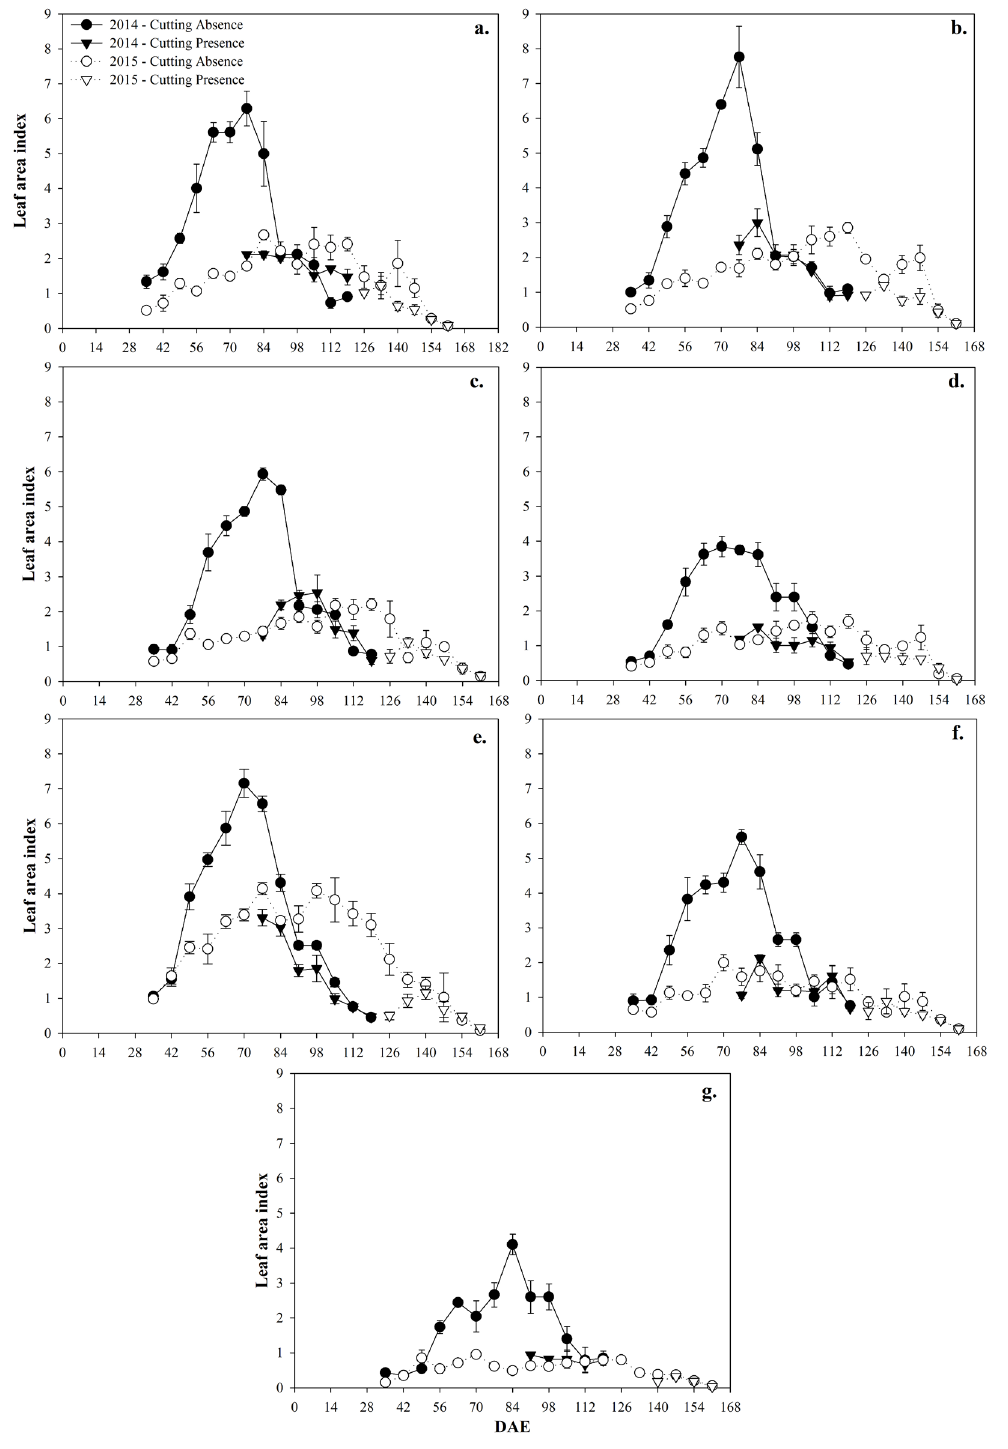
Figure 6 - Leaf area index (LAI) in days after emergency (DAE) dual-purpose wheat cultivated in different cropping systems and with or without a cut (grazing simulation) in the crop years of 2014 and 2015 (Crop Seasons I and II, respectively). S.parahyba Intercrop-I (a) ; P.rigida Intercrop-I (b) ; P.dubium Intercrop-I (c) ; and Intercrop-II (d) ; Monoculture (e) ; Eucalyptus Intercrop-I (f) ; e Intercrop-II (g)